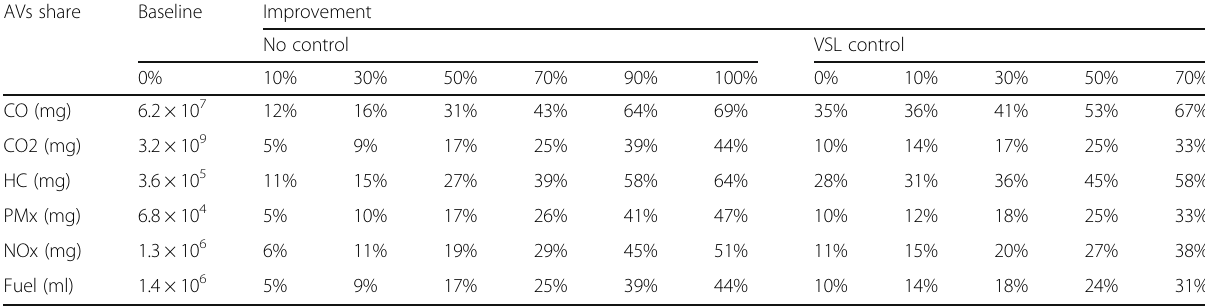
Table 1 Emissions and fuel consumption under heavily congested traffic AVs share